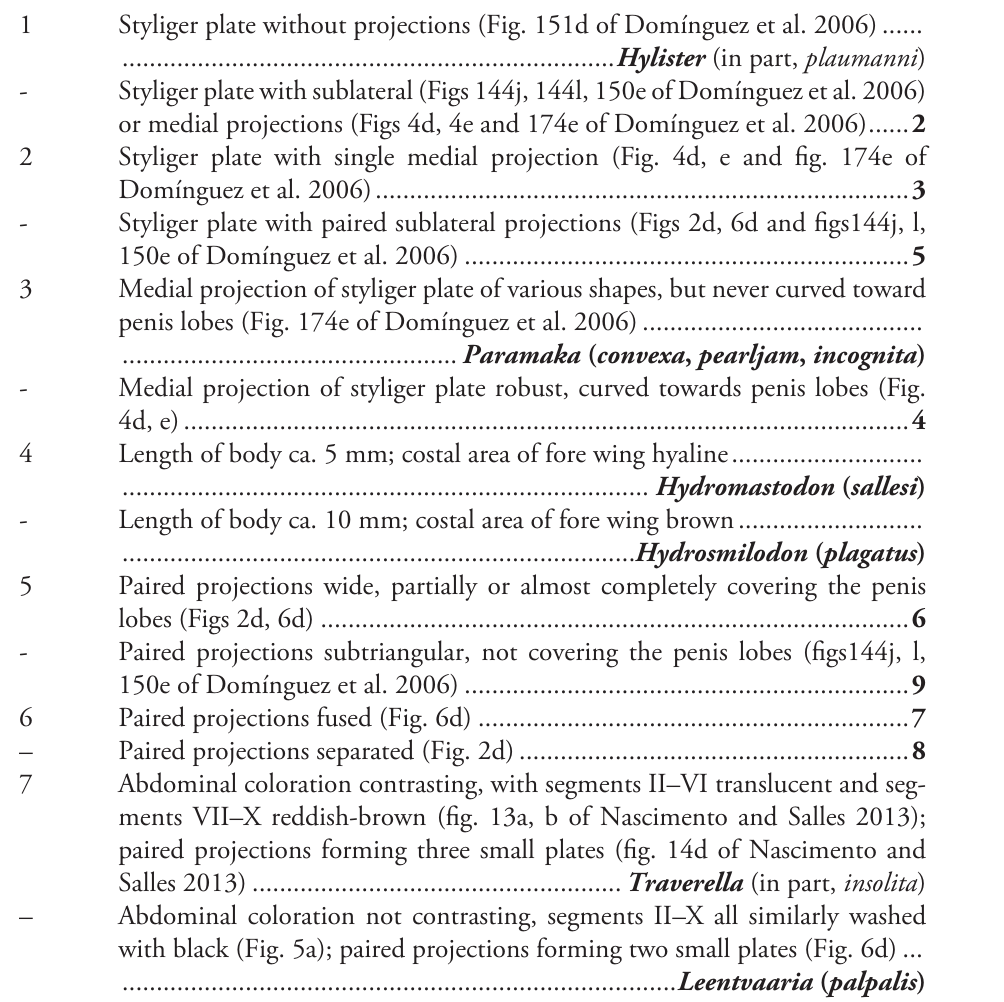
1 Styliger plate without projections (Fig. 151d of Domínguez et al. 2006) ...... - Styliger plate with sublateral (Figs 144j, 144l, 150e of Domínguez et al. 2006) or medial projections (Figs 4d, 4e and 174e of Domínguez et al. 2006) ...... 2 2 Styliger plate with single medial projection (Fig. 4d, e and fig. 174e of - Styliger plate with paired sublateral projections (Figs 2d, 6d and figs144j, l, 150e of Domínguez et al. 2006) ................................................................. 5 3 Medial projection of styliger plate of various shapes, but never curved toward penis lobes (Fig. 174e of Domínguez et al. 2006) ......................................... - Medial projection of styliger plate robust, curved towards penis lobes (Fig.